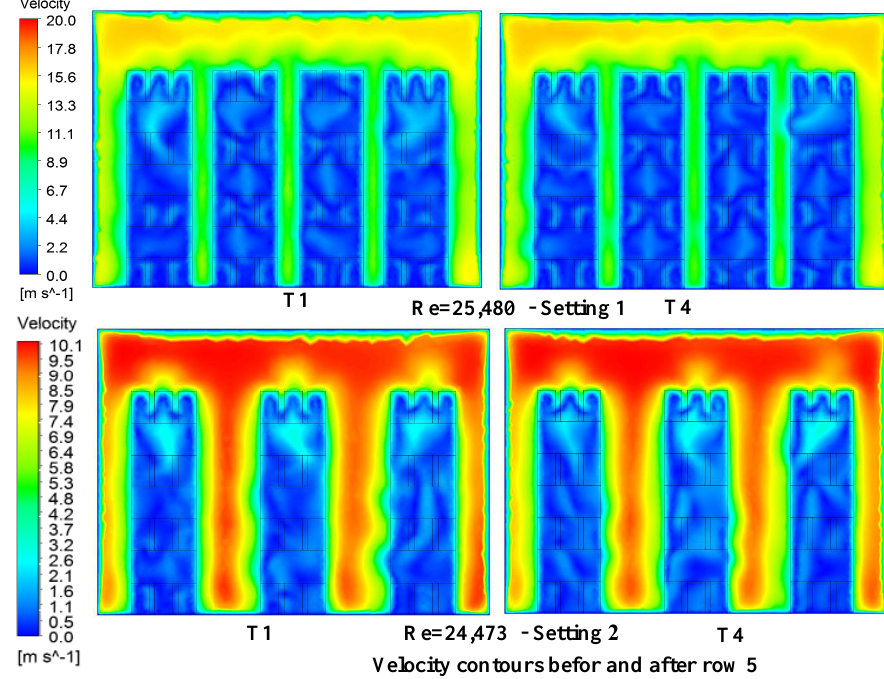
Figure 17. Velocity contours in transversal planes before and after the fifth row.